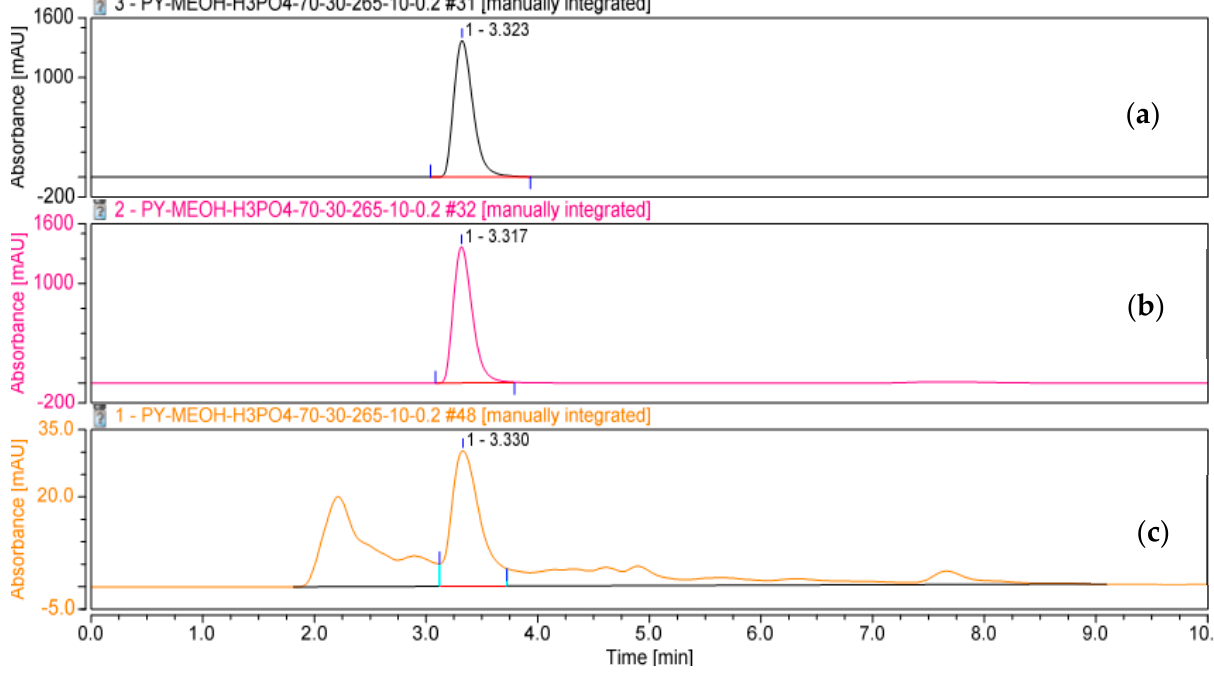
Figure 7. The HPLC fingerprinting of hemi ‐ pyocyanin (purified in this work ( a ), the reference compound ( b ), and the crude pigments ( c )).